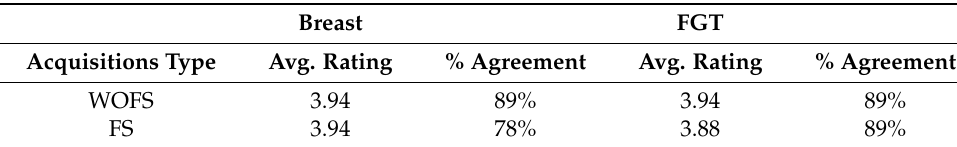
Table 5. Internal test set results (n = 9 patients, 18 acquisitions (9 WOFS, 9 FS)). Reader study overall